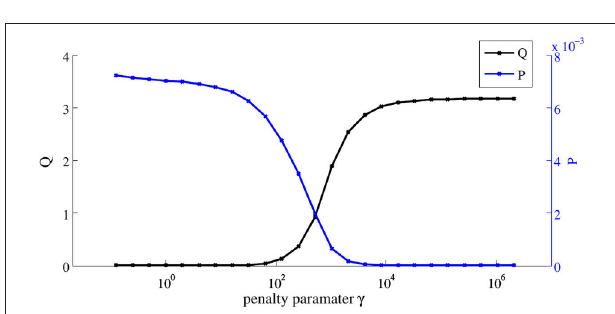
FIGURE 5 | The values of the quality term Q and the penalty term P for various values of the penalty parameter γ